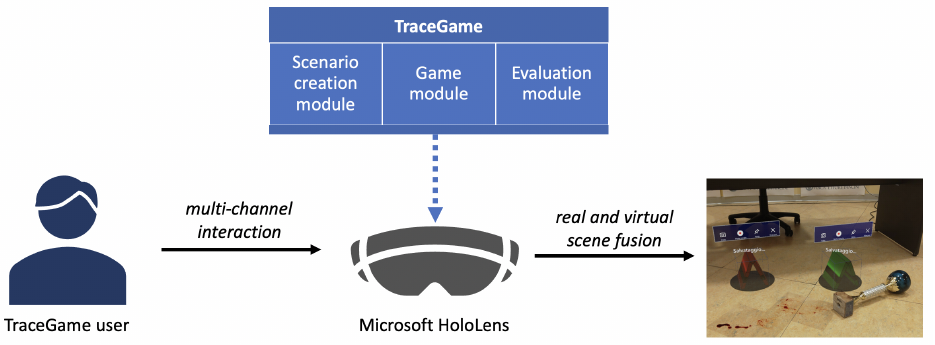
Figure 1. Architecture of the proposed framework.